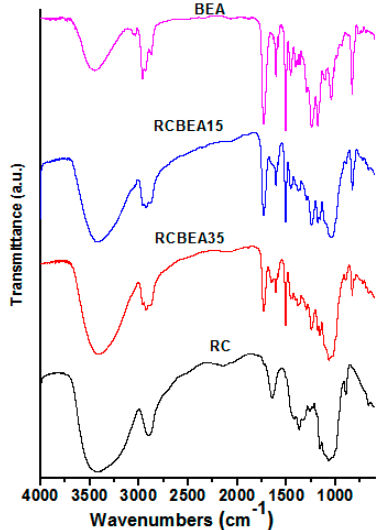
Figure 3. Fourier-transform infrared (FT-IR) spectra of the RC film, biphenyl A epoxy acrylate resin, and some composite films.